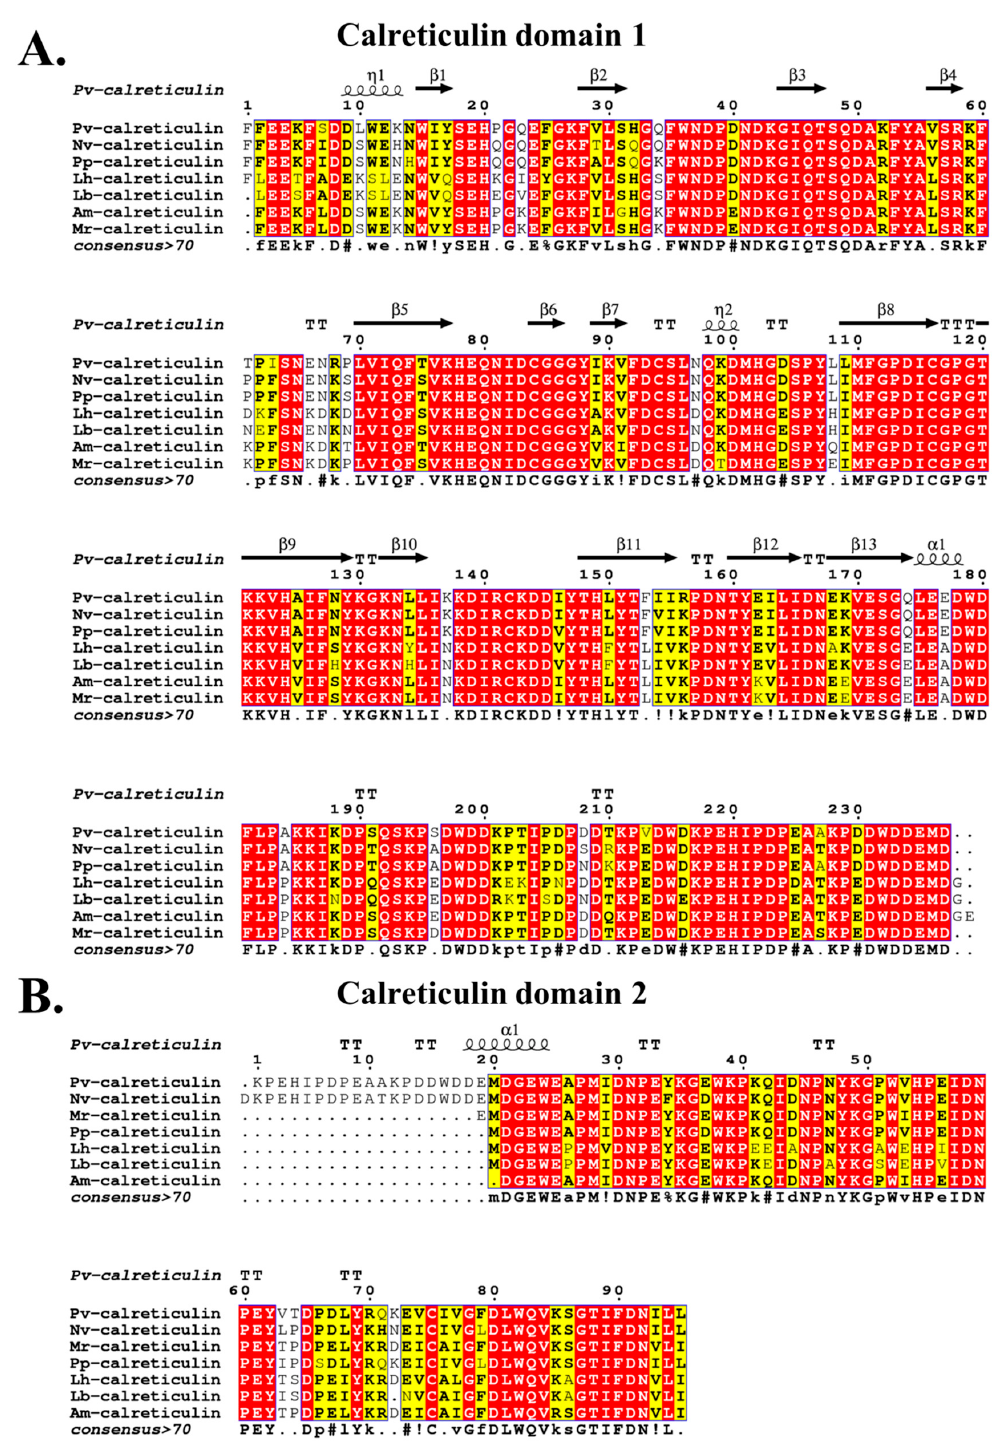
Figure 2. Multiple sequence alignments based on “calreticulin” domain 1 ( A ) and “calreticulin” domain 2 ( B ). Pv, P. vindemiae ; Nv, N. vitripennis (NP_001155151.1); Pp, P. puparum (ACZ68113.1); Lh, Leptopilina heterotoma (comp326_c0_seq1) and Lb, Leptopilina boulardi (comp263_c0_seq1) [43]; Am, Apis mellifera (XP_006559569.1); Mr, Megachile rotundata (XP_003701110.1). Multiple sequence alignments were conducted by Clustal Omega and visualized by ESPript 3.0 [32,44]. The conserved amino acid residues were highlighted, red means the entirely conserved amino acid residues and yellow represents the 70–100% conservation in amino acid